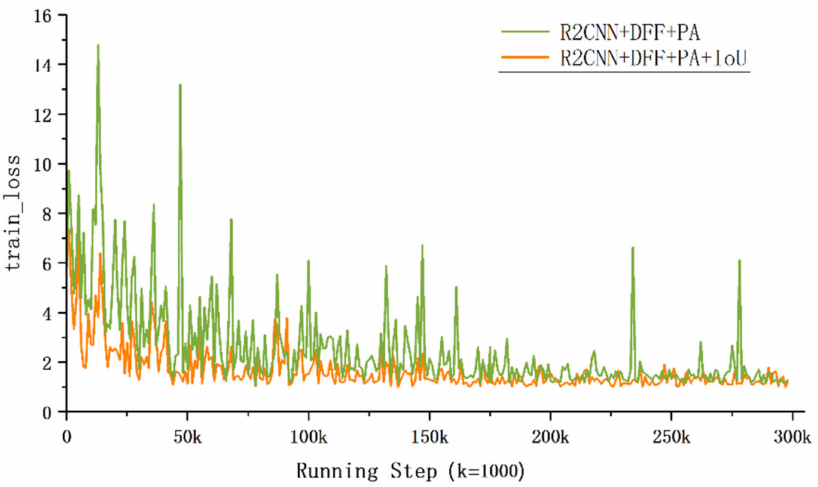
Figure 8. Different convergence processes of loss value during the training